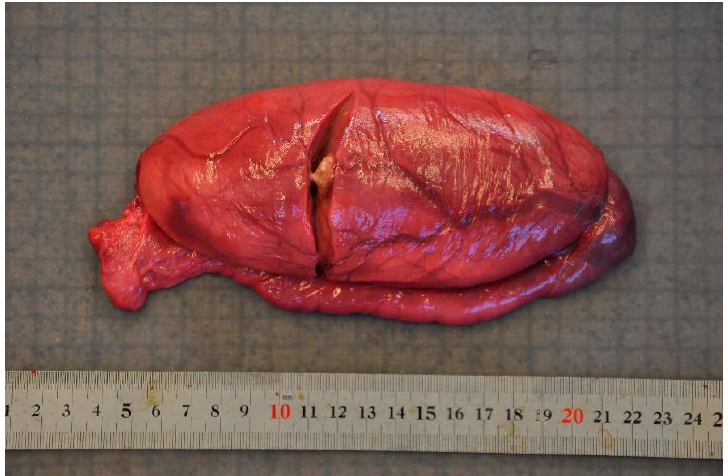
Figure 5. The focal, yellow, caseous abscess in the testis of an adult harbour porpoise ( Phocoena pho- coena ) caused by Brucella sp. infection. phocoena ) caused by Brucella sp.